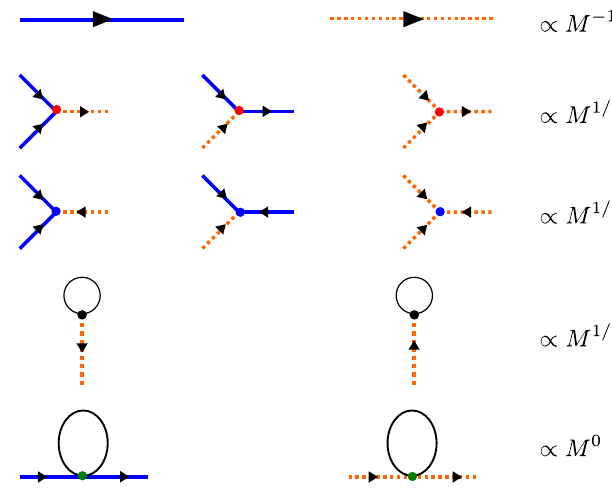
Fig. 5 Basic ingredients of the perturbative fi eld theory in 1/ M for Ba 2 F e Si 2 O 7 . Solid (dash) lines represent the bare propagator of the transverse (longitudinal) boson. The symmetry-allowed cubic vertices are shown on the second and third lines. The red (blue) dot represents a decay (sink) vertex. The cubic – linear vertices are listed on the fourth line. The last line represents the normal vertex V ð 4 ; N Þ αα from H ð 4 Þ